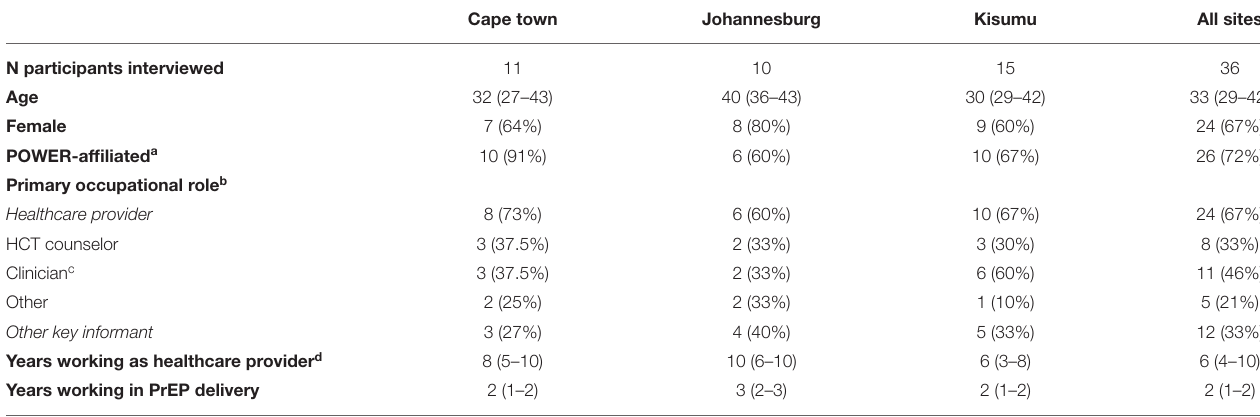
TABLE 1 | POWER key informant